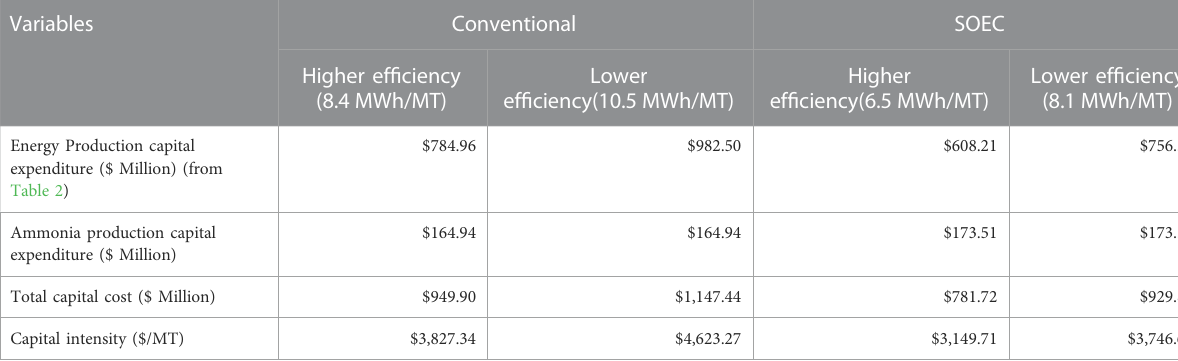
TABLE 3 Fixed and variable cost under energy conversion to ammonia